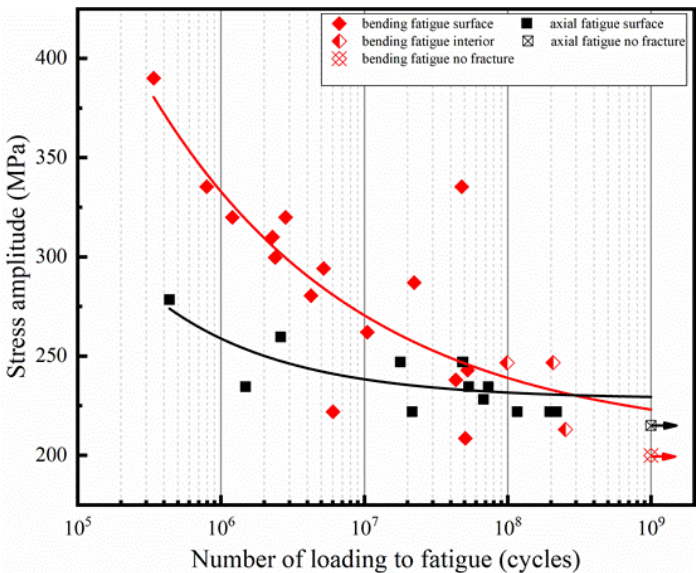
Figure 8. S-N data of the different loading styles involving the bending and axial specimens.